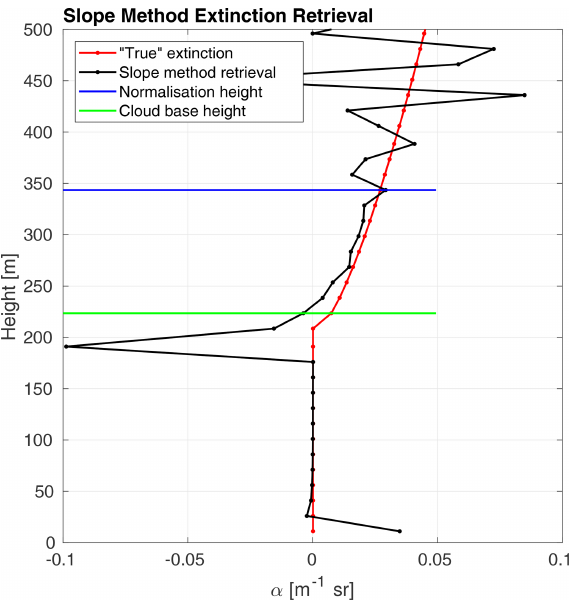
Figure 2. Profile of the extinction coefficient retrieved based on the slope method (Eq. 7) and the true extinction profile calculated from ECSIM.